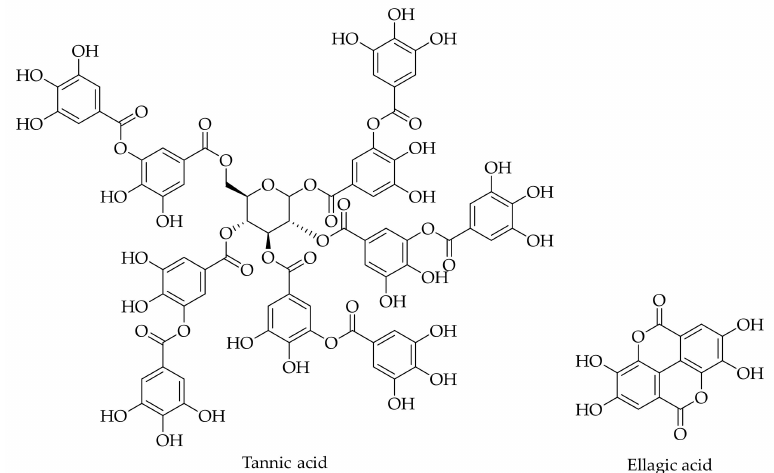
Figure 2. The chemical structures of di ff erent identified, isolated, and quantified hydrolysable tannins in the green husk of